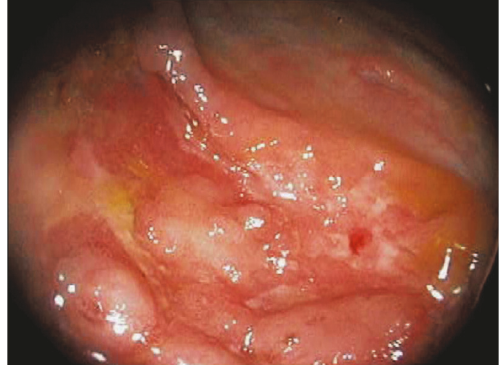
Figure 31: Endoscopic image of the cecum in a patient with Crohn’s colitis. The ulcerations are generally large, deep, serpiginous, or geo- graphic in morphology.